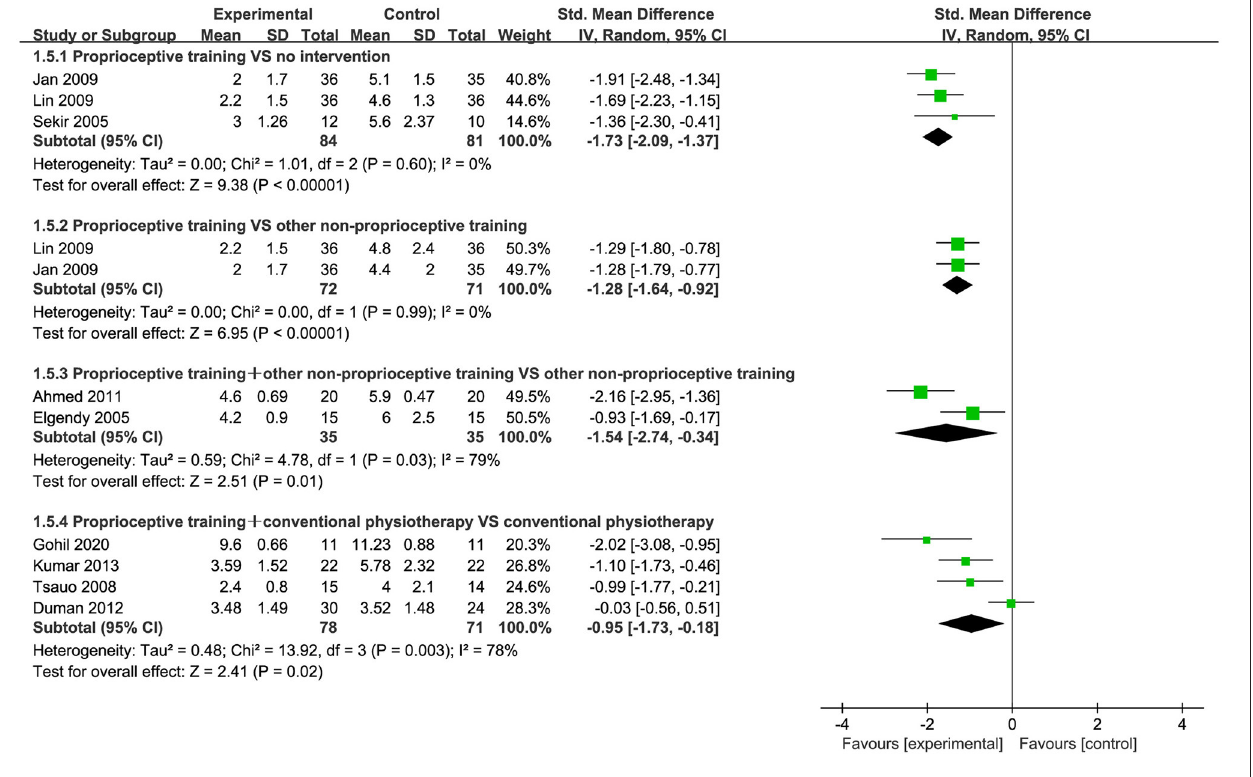
FIGURE 6 | Forest plot of meta-analysis on JPS.